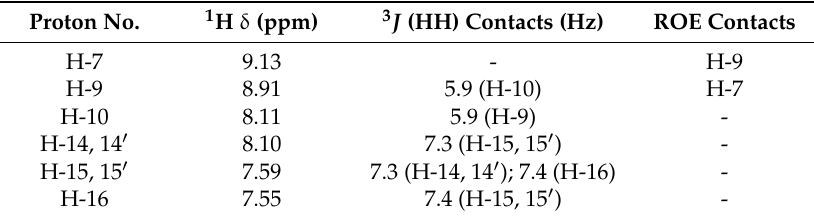
Table 2. 1 H-NMR data for 7 .